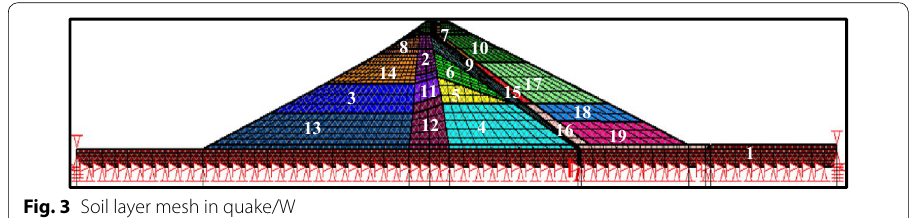
Fig. 3 Soil layer mesh in